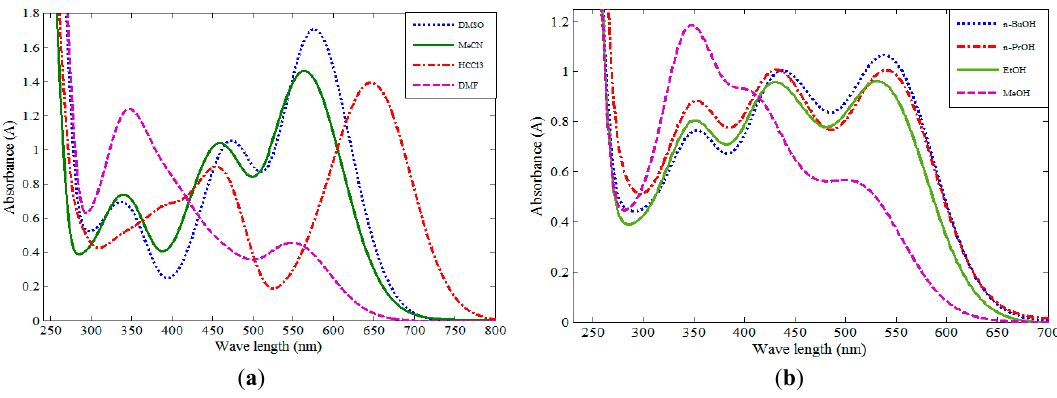
Figure 3. Electronic absorption spectra of 2.0 × 10 − 5 M compound 4e : ( a ) In dimethylsulfoxide (DMSO), MeCN, HCCl 3 and dimethylformamide (DMF); ( b ) In n -butanol, n -propanol, ethanol and methanol.